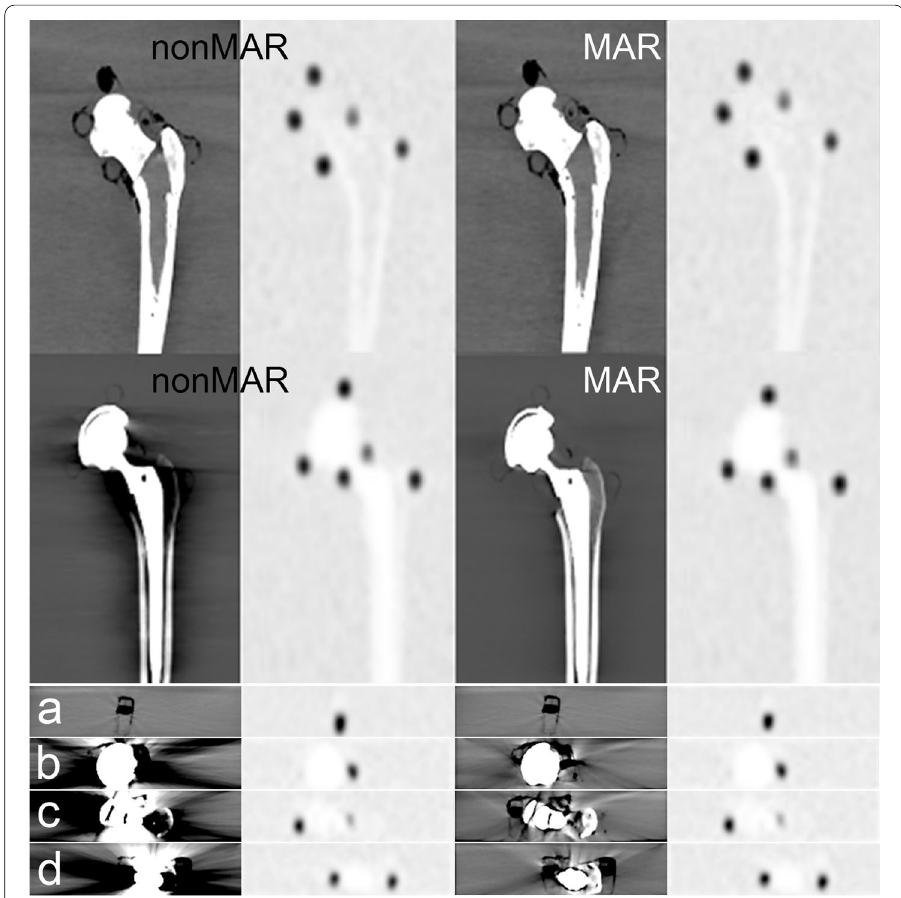
Fig. 2 PET and CT images from the phantom experiment. Results of the scam experiment are shown in the upper row. Further rows show the results of the prosthesis experiment. The two columns to the left are not corrected by MAR, those to the right are. Corresponding CT (left) and PET (right) images are given. The top two rows show coronal images; to indicate the position of the sources, which were not all in the same coronal plane, the PET images are composites of several slices. The lower rows show axial slices at the level of the lateral acetabular source (row a), the lateral neck source (row b), the medial acetabular source (row c), and the medial neck source and the trochanteric source (row d). Some air visible in the sources is due to incomplete filling of the tubes. Note the dark streak artefacts around the prosthesis, which largely disappear from the MAR corrected CT. White streak artefacts are mainly situated anterior and posterior to the